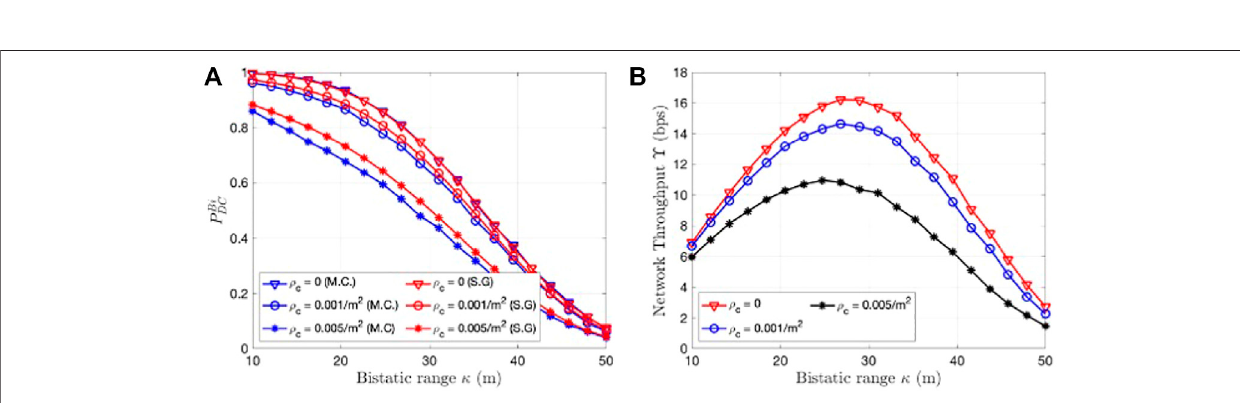
FIGURE 6 | (A) Detection coverage ( P Bi DC ) and (B) network throughput ( ϒ ) as a function of bistatic range ( κ m ) for parametric clutter density ( ρ c ).